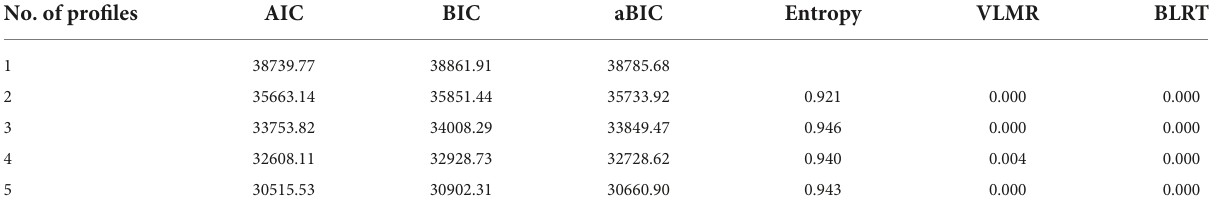
TABLE 2 Model fit results of latent profile analyses.